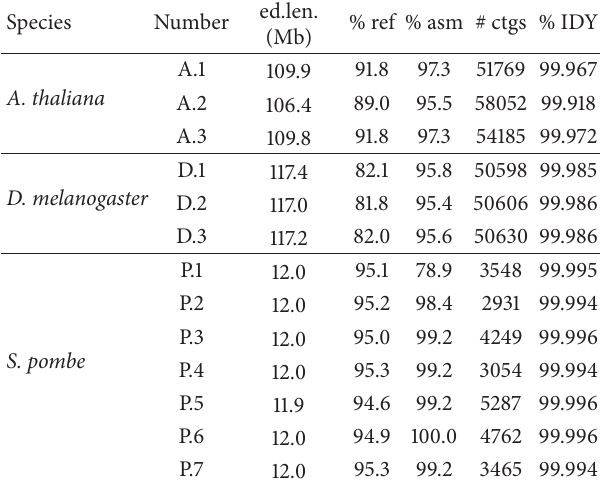
Table 3: Assembly of real experimental reads (edited reference). Species